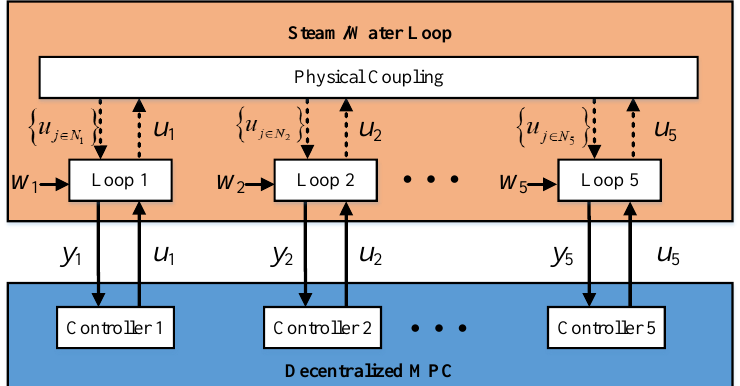
Figure 6. A conceptual representation of the decentralized MPC architecture [33] (Reproduced with permission from Maxim, A.; Copot, D.; De Keyser, R.; and Ionescu, C.M., Journal of Process Control; published by Elsevier, 2018).